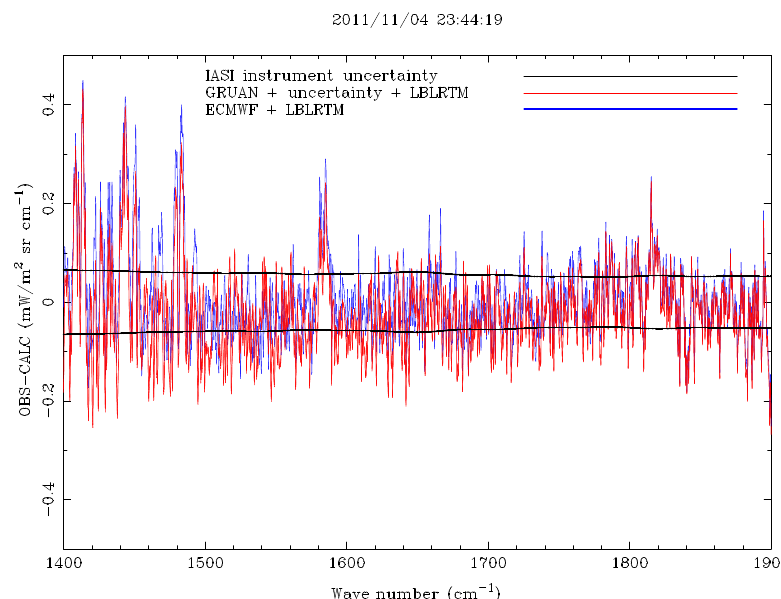
Figure 3. IASI observed minus calculated radiances (OBS − CALC) for a sample sonde (4 November 2011 23:44:19Z). Calculated radiances derived from LBLRTM and GRUAN sondes (red) and ECMWF (blue). IASI overall instrument uncertainty (black). The thickness of the red line (hardly noticeable) denotes the GRUAN uncertainty propagated into radiance space assuming no uncertainty correlation between levels.